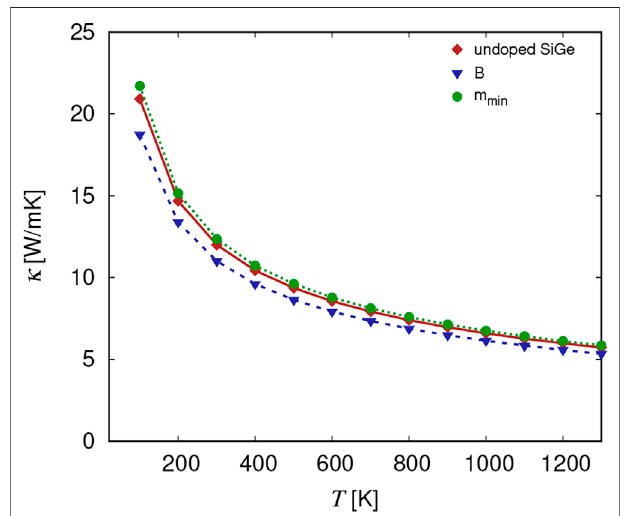
FIGURE 6 | Thermal conductivity in undoped Si 0.5 Ge 0.5 (red diamonds) and doped with B (blue triangles) and a fi ctitious species with mass m min (green circles) at a concentration of 10 21 cm − 3 as a function of temperature.